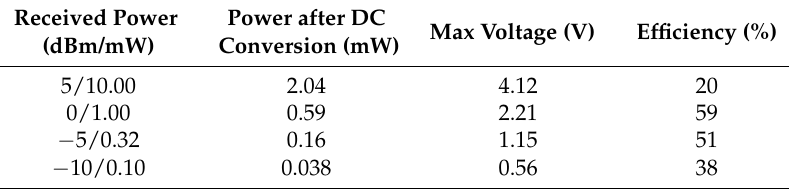
Table 4. Radio frequency to direct current converter